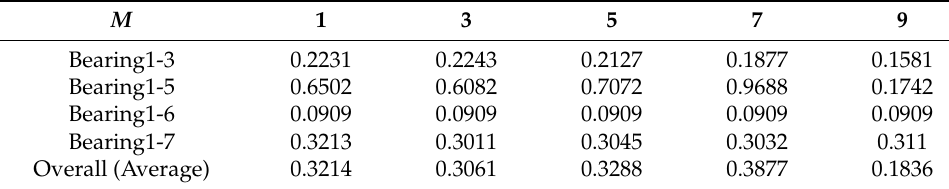
Table 7. Scores of RUL estimation scores with M = 1, 3, 5, 7, and